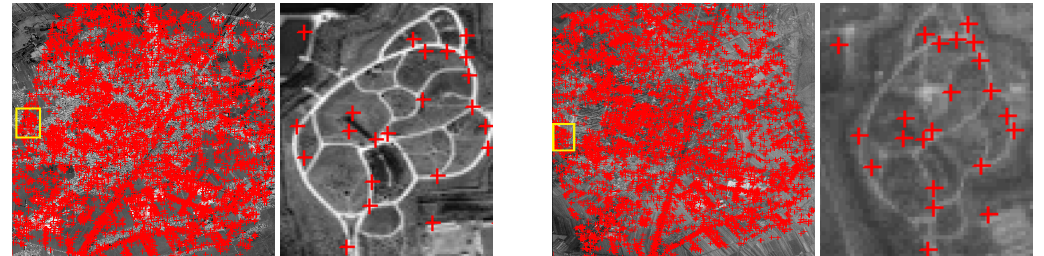
Figure 17. The matching result produced by the proposed method. The zoomed views of a local region, which is marked with a rectangle in each image, are provided to show the matching details.